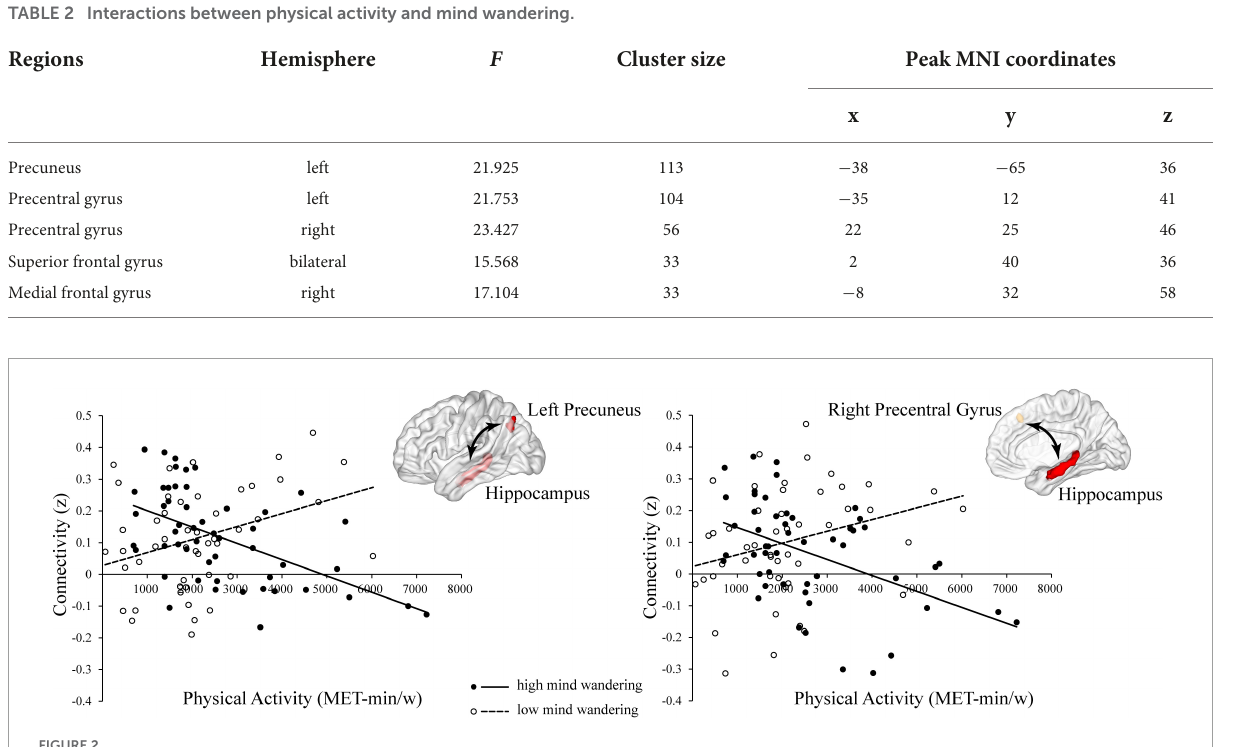
FIGURE2 Negative relations between physical activity and hippocampal functional connectivity at left precuneus and right precentral gyrus in high mind wandering group.